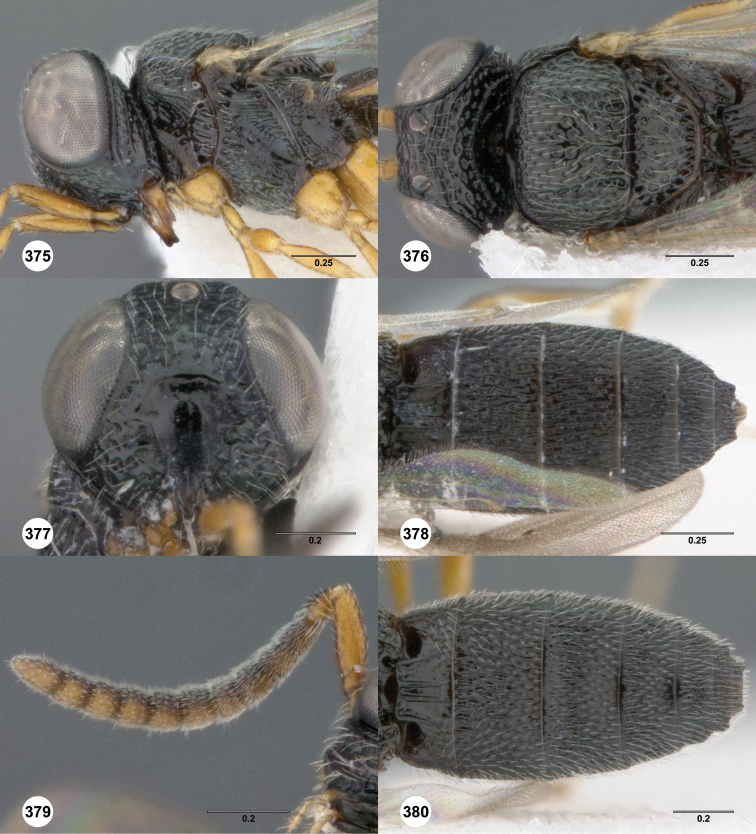
Oxyscelio umbonis sp. n., holotype female (OSUC 438236) 375 Head and mesosoma, lateral view 376 Head and mesosoma, dorsal view 377 Head, anterior view 378 Metasoma, dorsal view. Paratype male (OSUC 438271) 379 Antenna 380 Metasoma, dorsal view. Morphbank99